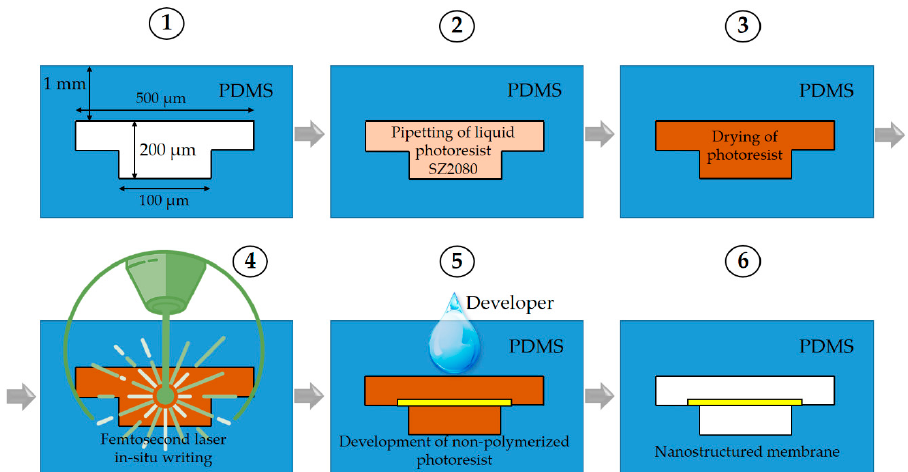
Figure 2. Proposed fabrication steps for printing of the microstructured membrane inside a closed microfluidic channel in polydimethylsiloxane